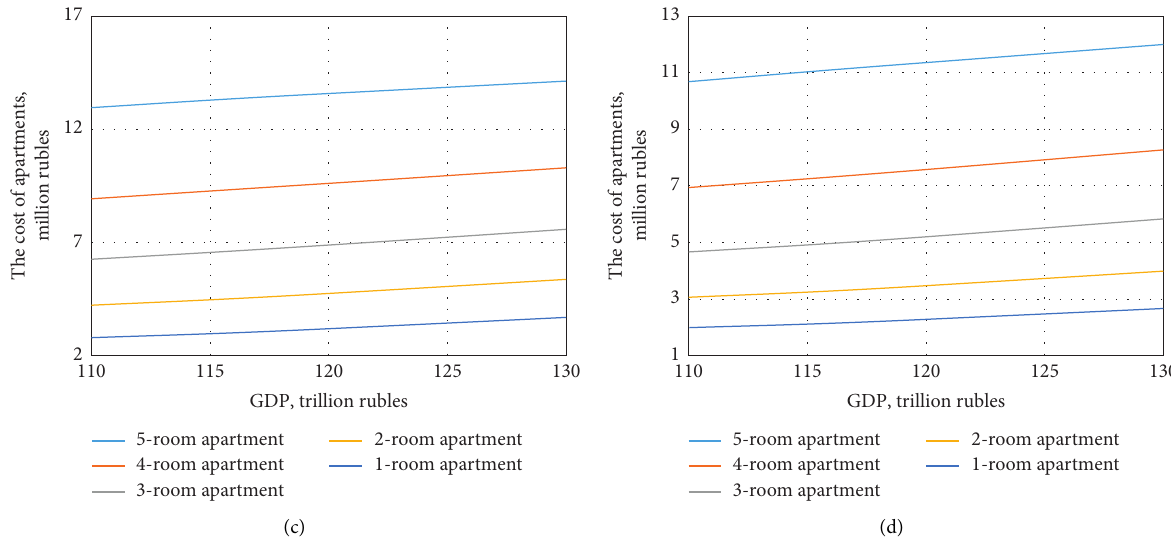
Figure 9: Forecast of the dependence of apartment costs in Russian cities on the country’s GDP. (a) Moscow, (b) Saint Petersburg, (c) Yekaterinburg, and (d)